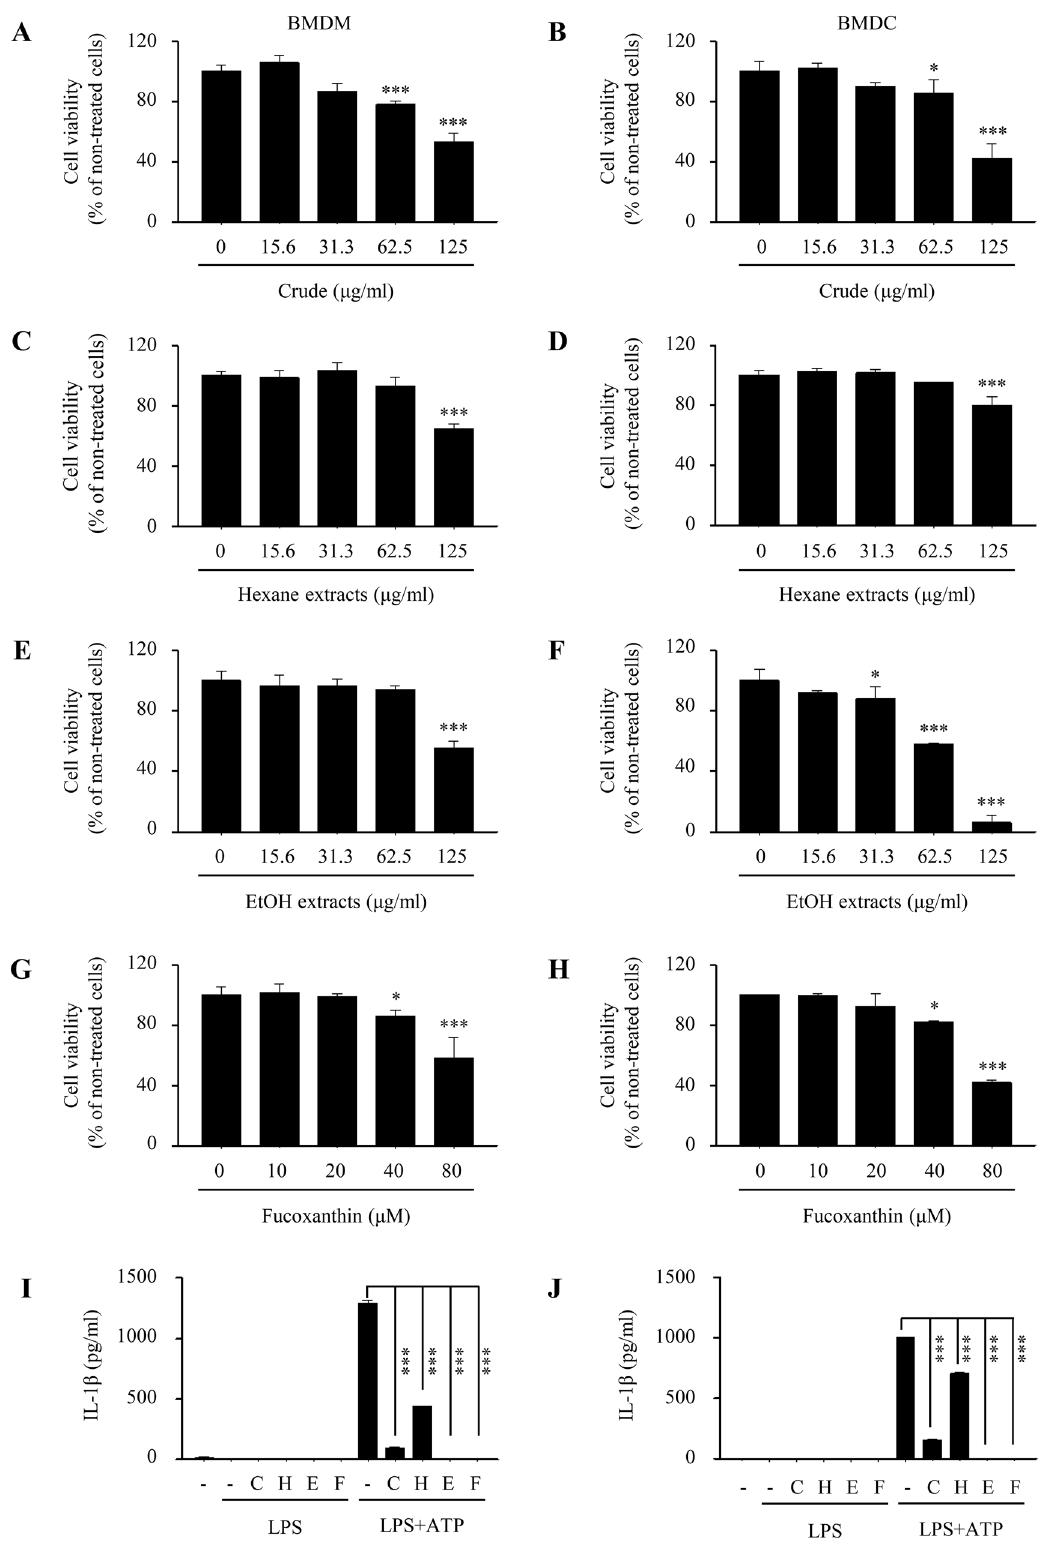
Figure 2. Effect of Phaeodactylum tricornutum extracts on cell viability and IL-1β production in bone marrow- derived macrophages (BMDMs) and dendritic cells (BMDCs). ( A–H ) BMDMs and BMDCs were treated with crude ( A , B ), hexane ( C , D ), ethanol ( E , F ) extracts and fucoxanthin ( G , H ) at various concentrations. Cell viability was then measured by MTT assay. ( I , J ) BMDMs and BMDCs were pre-treated with crude (62.5 μg/ml), hexane (62.5 μg/ml), ethanol (31.3 μg/ml), and fucoxanthin (40 μM) 4 h prior to treatment of LPS (1 μg/ml) and ATP (5 mM). C, Crude; H, Hexane; E, Ethanol. Data are presented as mean ± SEM. * P ≤ 0.05 and *** P ≤ 0.001 (one-way ANOVA followed by Bonferroni’s post hoc comparisons